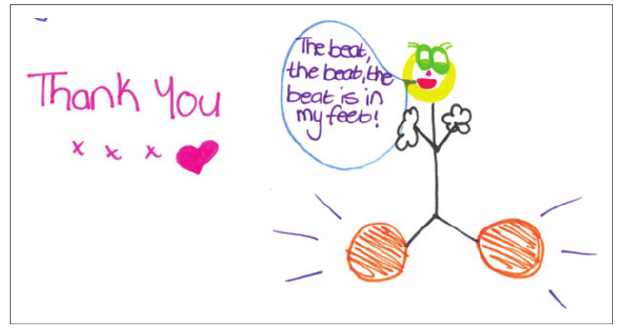
FIGURE 9: Student’s ‘playful’ conclusion at the end of the post-intervention